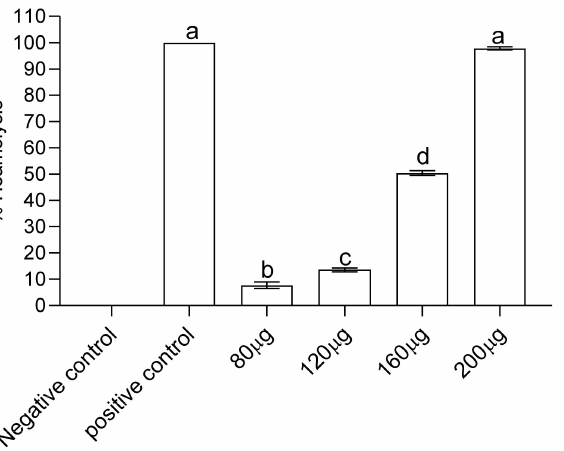
Figure 3. Hemolytic activity of flower methanolic extract of P. hysterophorus. Different alphabets (a, b, c & d) on bar graph show significant difference while same alphabets show no significant difference ( p <